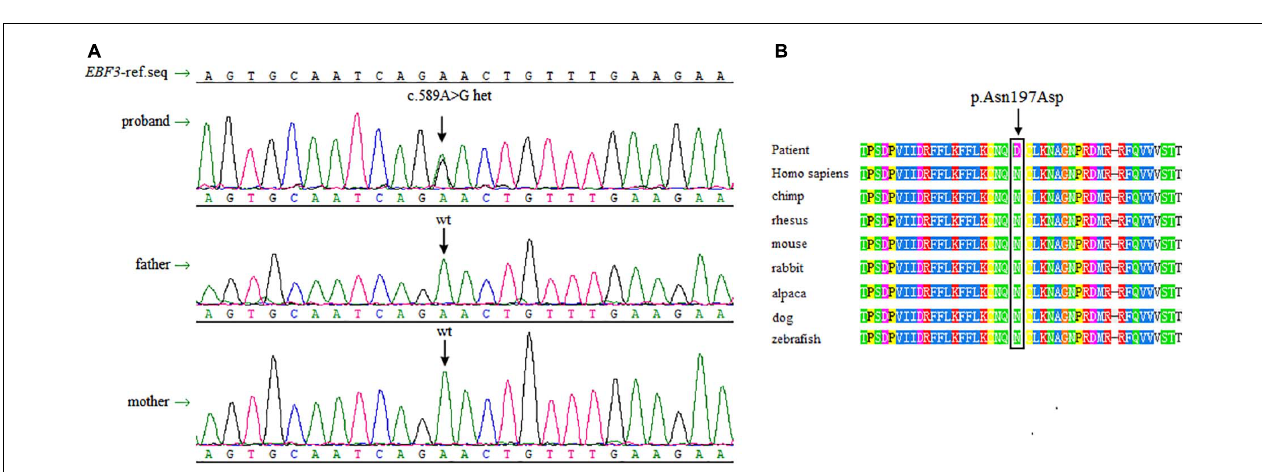
FIGURE 2 | Sanger sequencing data and conservation of the amino acid residues around the mutation sites. (A) Sanger sequencing shows a heterozygous mutation of c.589A > G in EBF3 is present in the proband, whereas both of the parents are wild-type for this variant. (B) The box shows the change is located at the conserved leucine residues. The mutated amino acid is highly conserved in 8